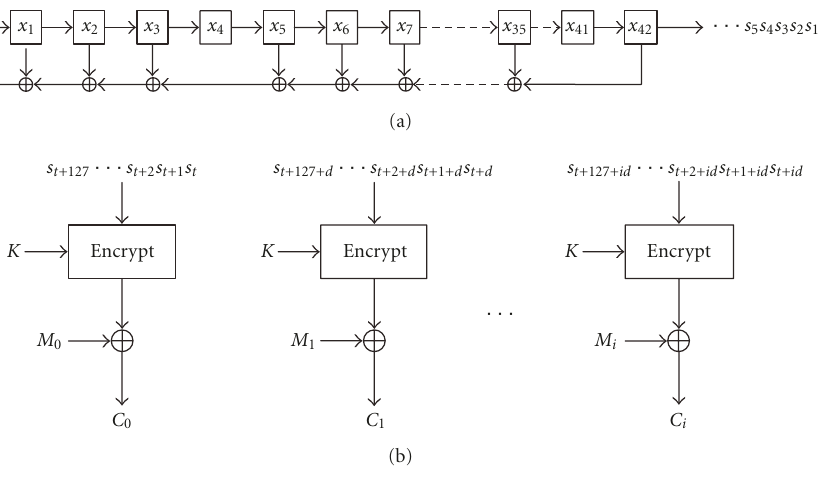
Figure 4: Proposed CDMA physical layer secure